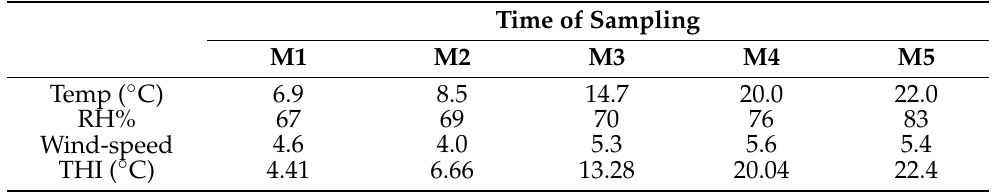
Table 1. Average monthly climatic data (February–June) during the